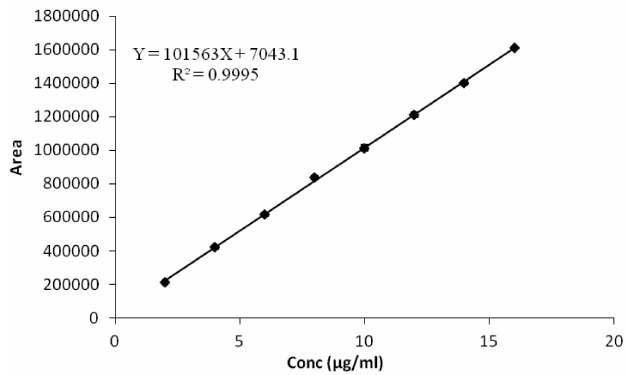
FIGURE 2 - Calibration curve of haloperidol by HPLC method.